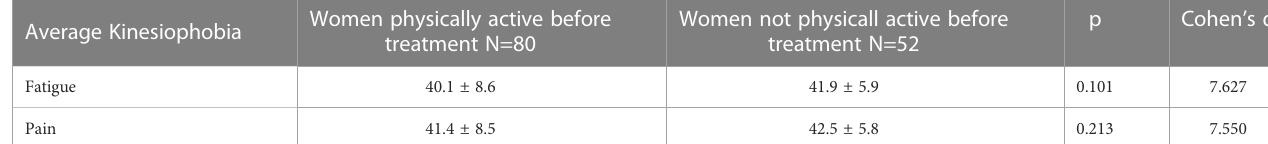
TABLE 4 Level of kinesiophobia and lifestyle – the impact of lifestyle before diagnosis on the level of kinesiophobia during cancer treatment.